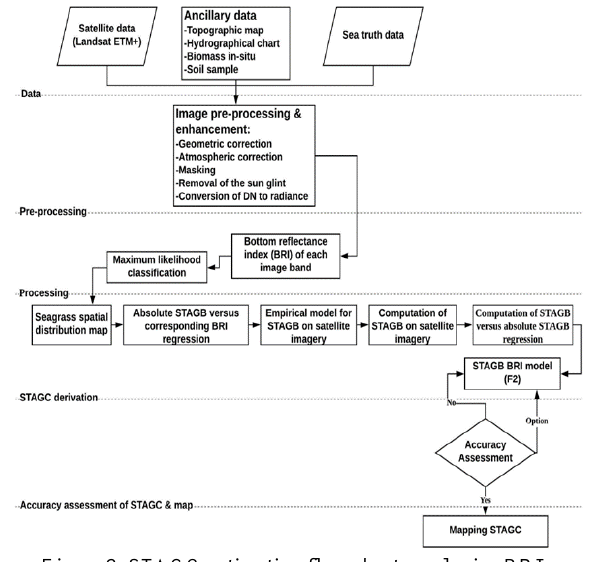
Figure 2. STAGC estimation flow chart employing